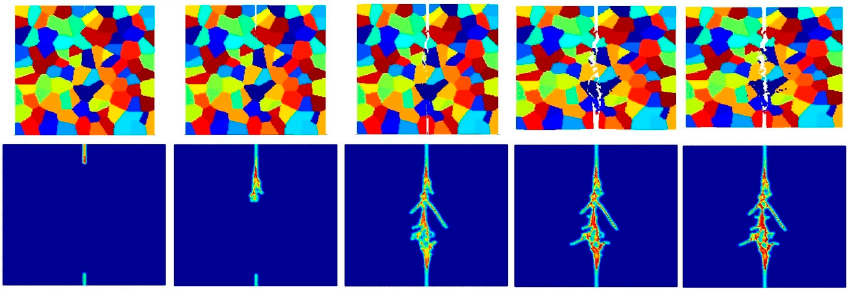
Figure 18. Fracture pattern of polycrystal when β = 1.0 with 150 × 150 particles. From left to right: time = 1.5 µ s, 2.0 µ s, 2.5 µ s, 3.0 µ s, and 3.5 µ s, respectively.